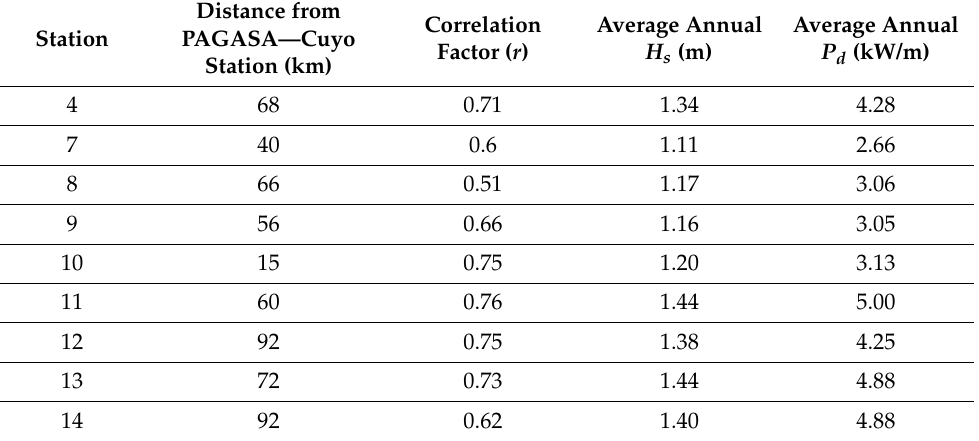
Table 2. Correlation between hindcast H s data from MOV and PAGASA measured wind speed. Distance from Correlation Station PAGASA—Cuyo Factor ( r ) Station (km)